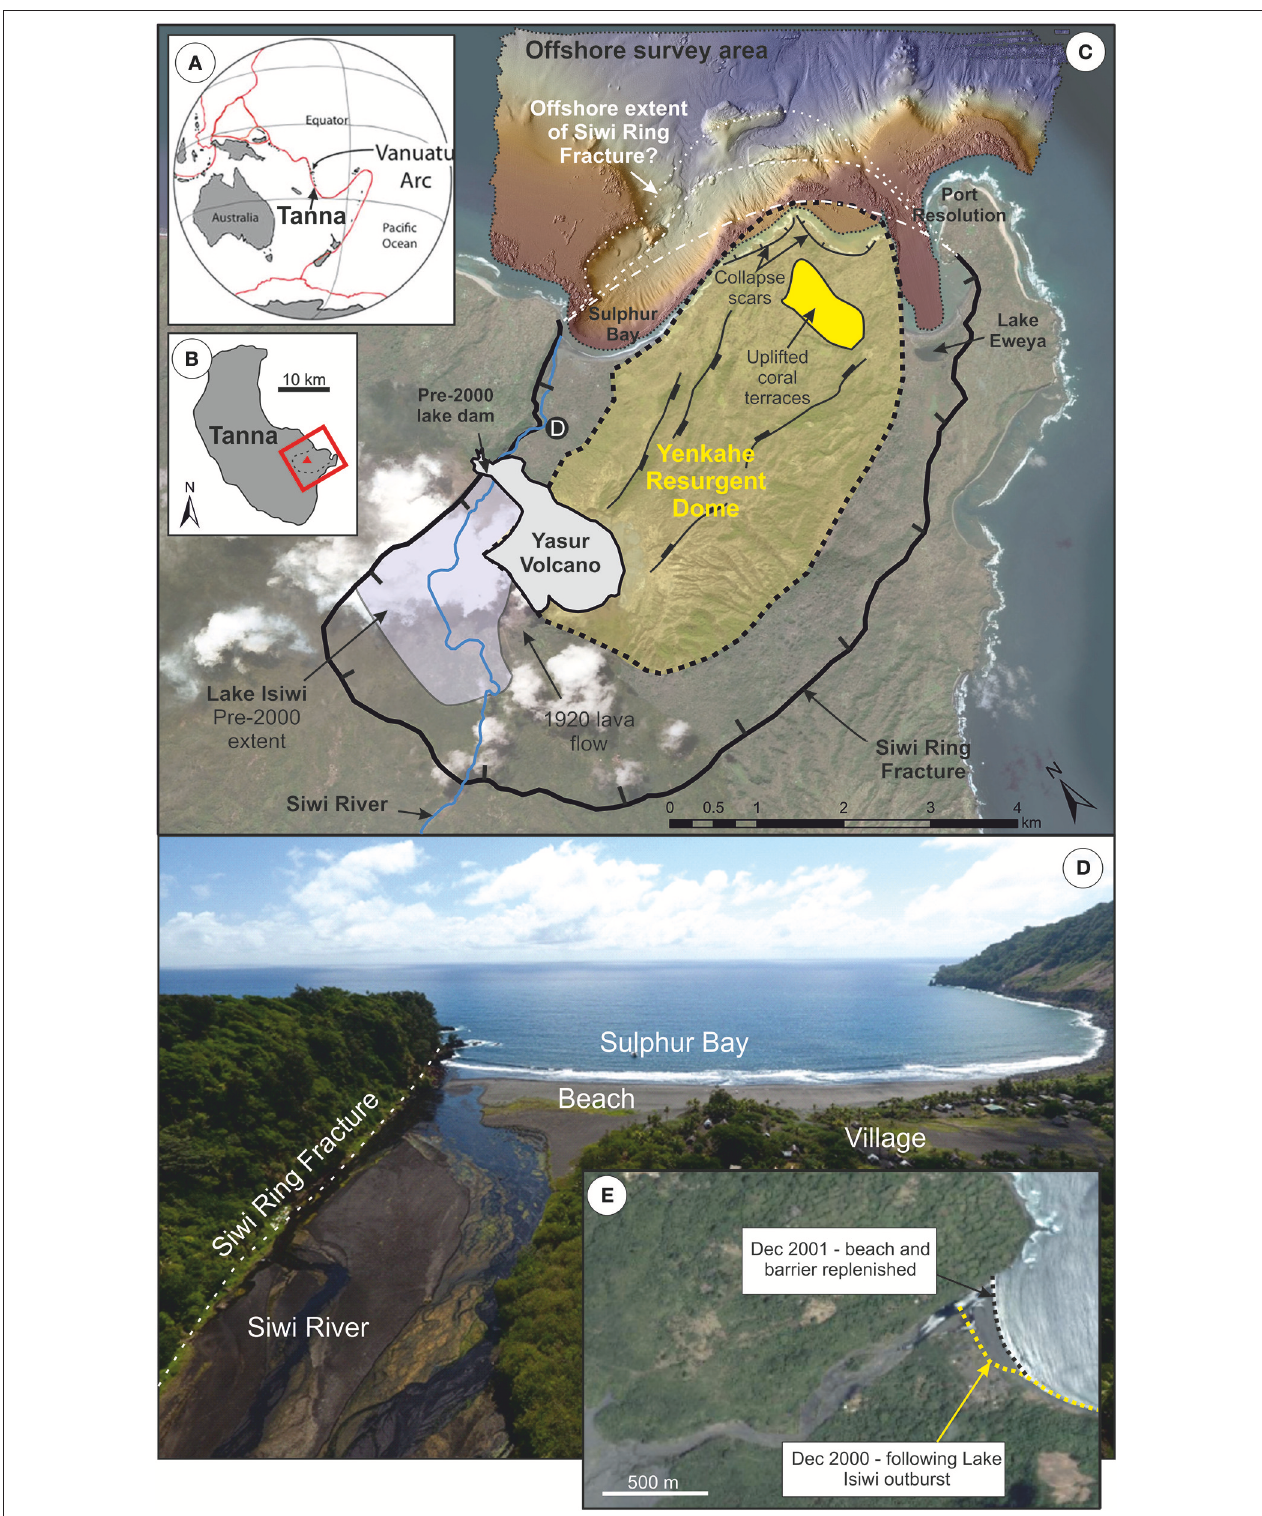
FIGURE 1 | (A) Location of Vanuatu Arc and (B) Tanna Island. Location and extent of survey area offshore Tanna Island, Vanuatu (C) shown in relation to onshore features. Onshore geomorphological and structural mapping based on Firth et al. (2014) and recreated under Copyright License 4433040166144. Three possible locations of the offshore extent of the Siwi Ring Fracture are annotated in white. Terrestrial photography from Google: Digital Globe. Aerial drone photograph (D) of Siwi River and Sulfur Bay taken toward the north-east at point D annotated on panel C. Satellite photograph (E) taken in 2001, following outburst flood in the Siwi River in 2000. December 2000 coastline is annotate in yellow.